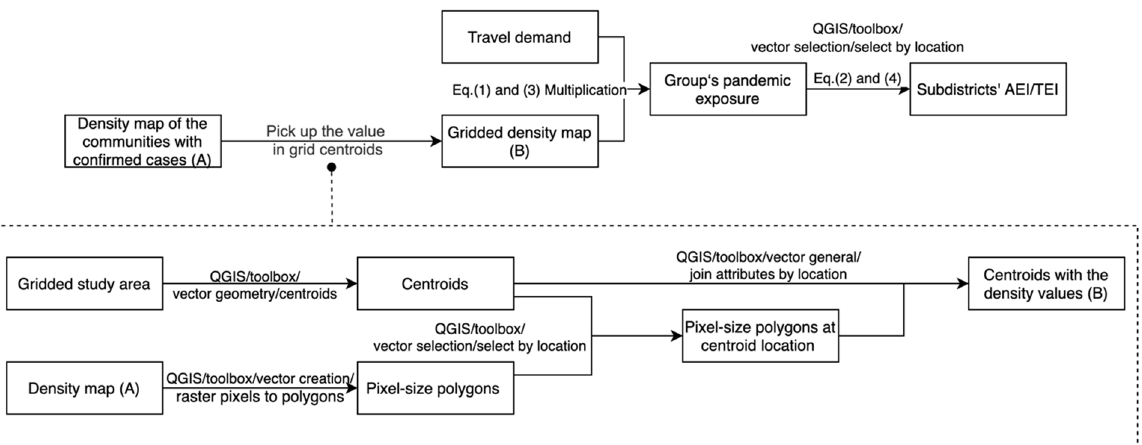
Figure 11. The workflow used to calculate the group’s coronavirus 2019 (COVID-19)-exposure vector field and indicators.